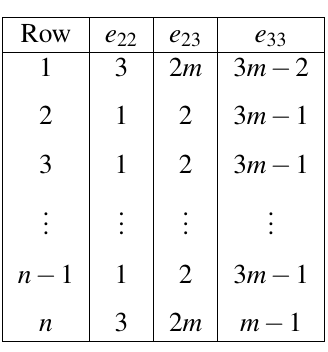
Table 1 Number of edges in each row of G ( m , n )